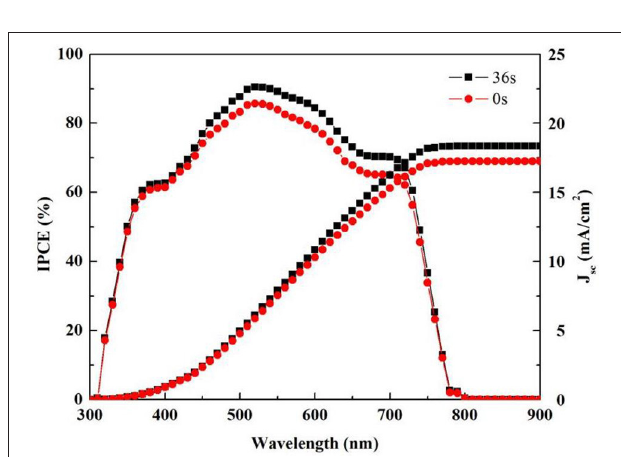
FIGURE 6 | IPCE spectra of the PSCs and the integrated current densities obtained from the corresponding IPCE spectra.